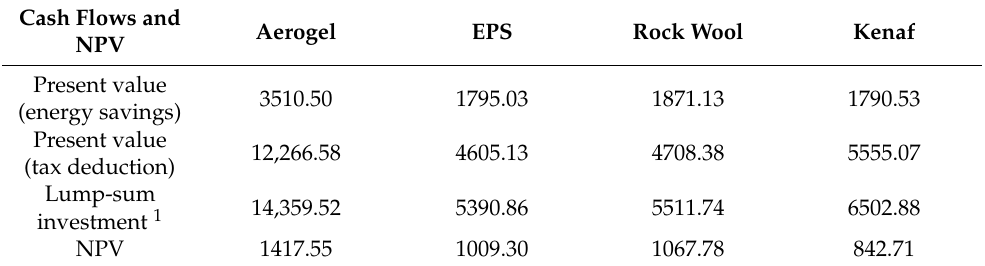
Table 9. Calculation of the Net Present Value (NPV) of materials (data in